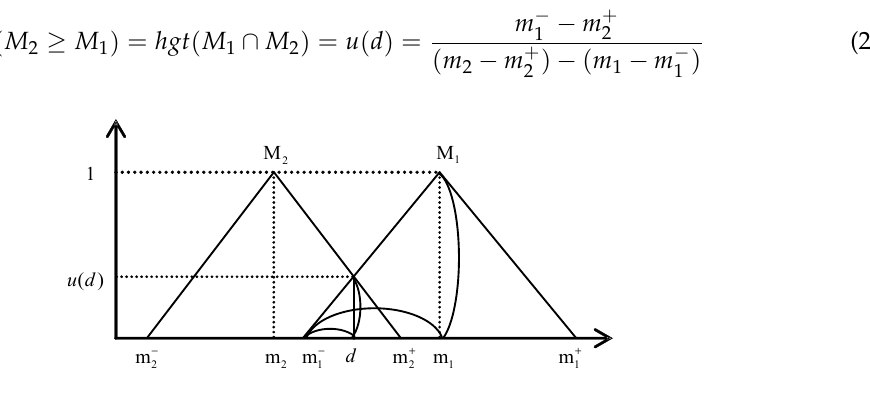
Figure 1. Two triangular fuzzy numbers M 1 and M 2 [26].